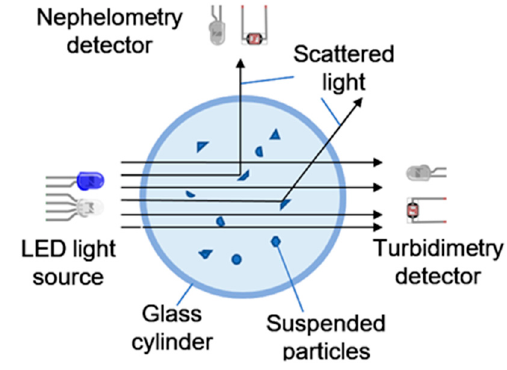
Figure 1. Diagram of operation of a turbidimeter and nephelometer.